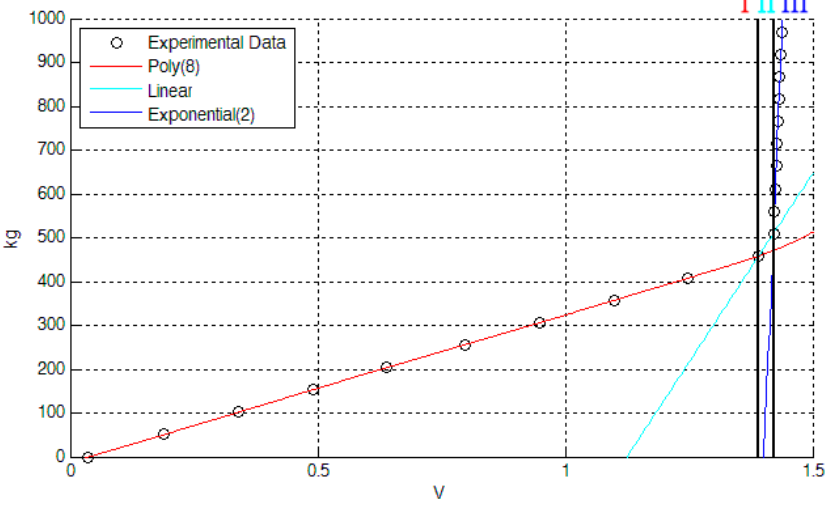
Figure 8. LC calibration curve in the low-power configuration showing the three region curve.